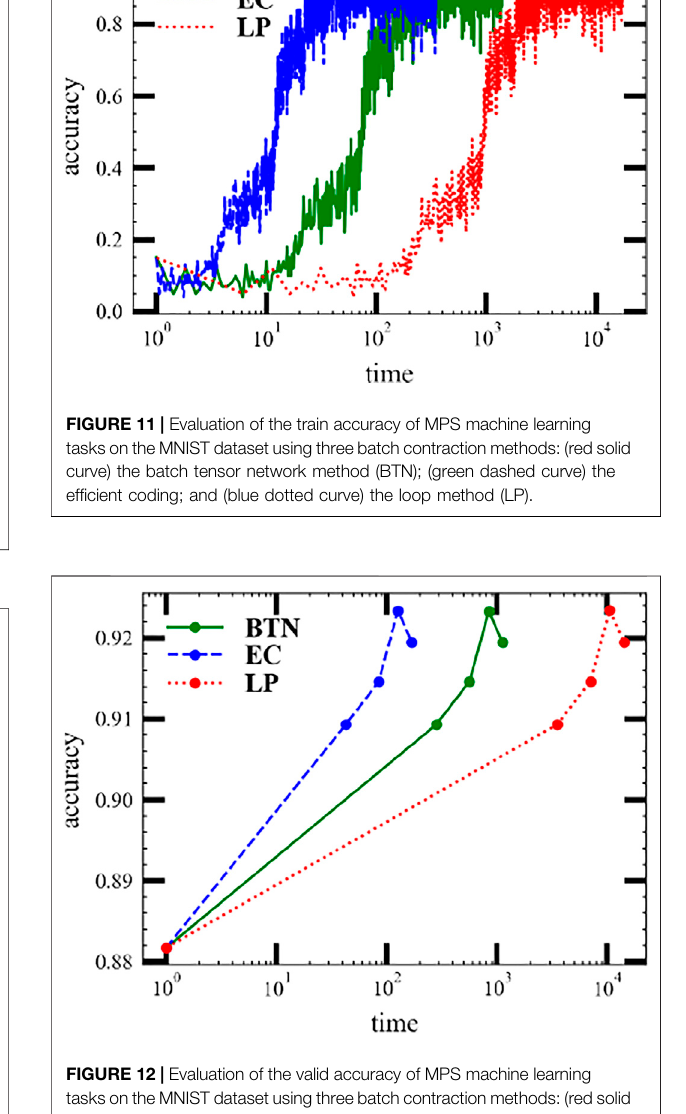
FIGURE 10 | Memory required for the increasing auxiliary bond dimension MPS machine learning problem. The system is an MPS with L = 21 units, with each unit assigned with B = 10, k = 3, D = 1, O = 10. The green curve ( BTN ) is the required memory for the BTN method and the blue curve ( EC ) is the required memory for the EC method.